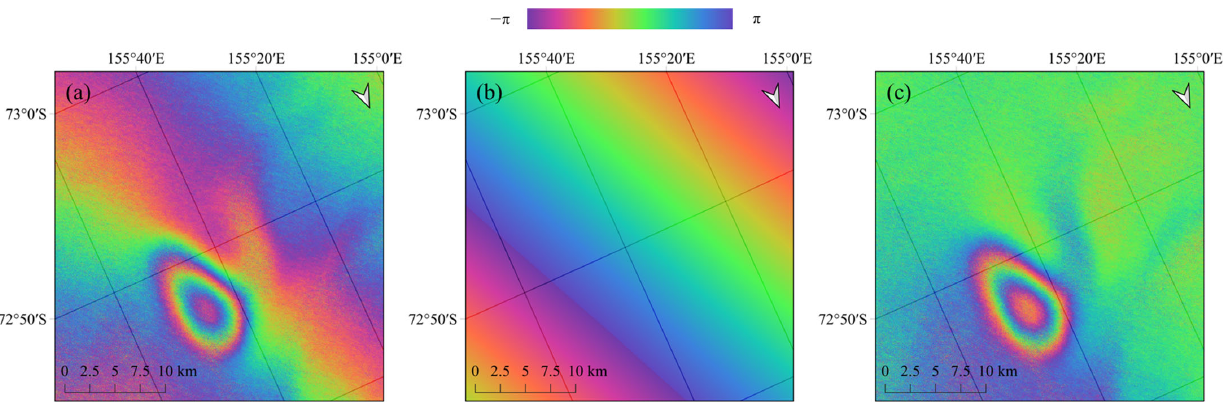
Figure 3. Trend line comparison of Sentinel-1 time series vertical displacement using DInSAR and ICESat-2 altimeter data (modified from Lee and Seo [43]).